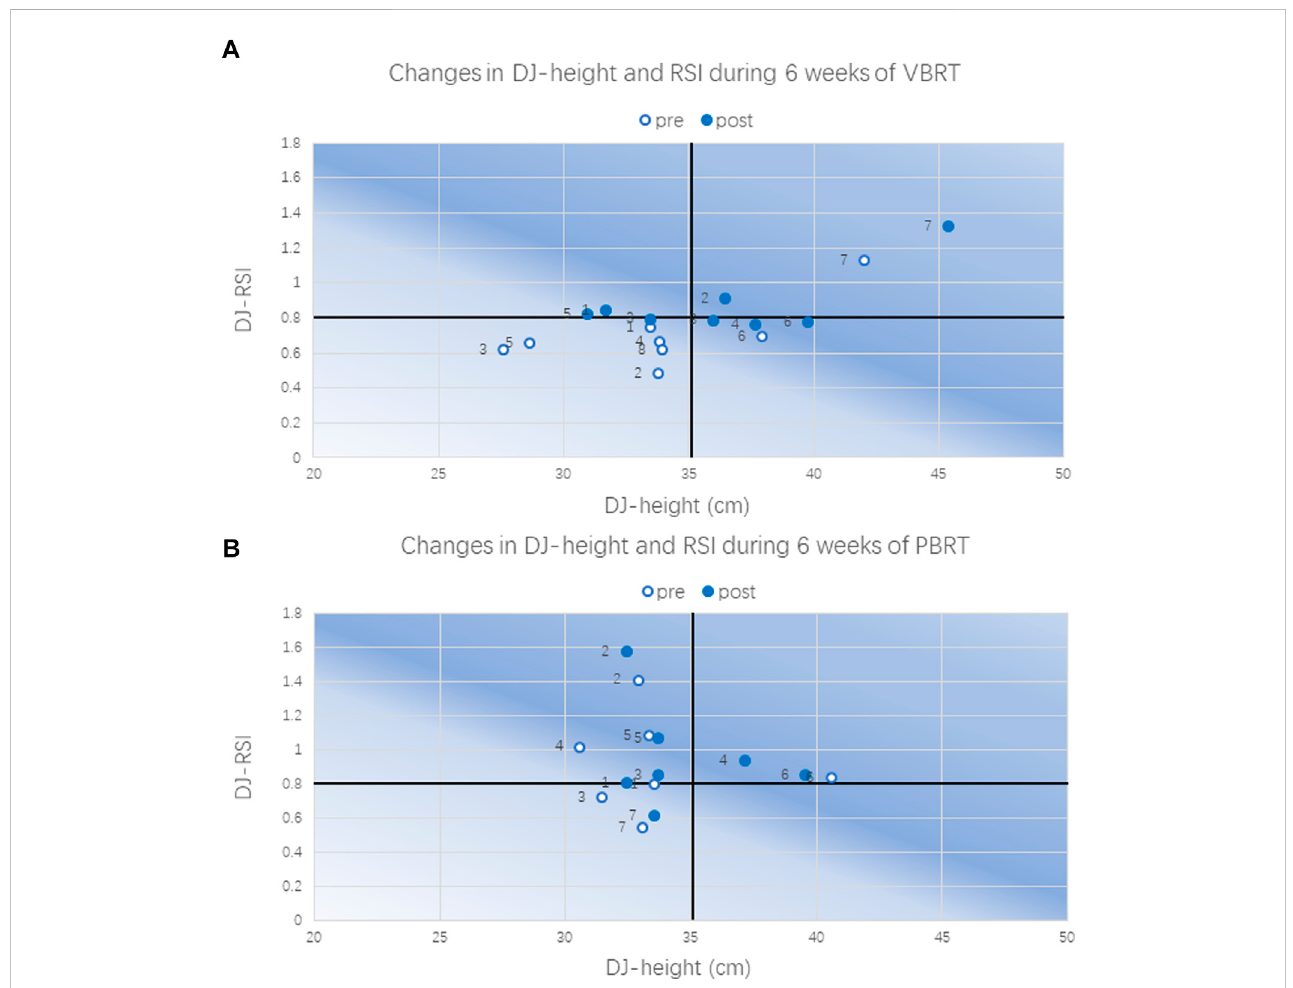
FIGURE 7 Four-quadrantdiagramof changes inDJ-height and RSI inVBRT (A) or PBRT (B) .DJ-height and DJ-RSI: theheightand reactivestrength index of40 cm drop jump test.